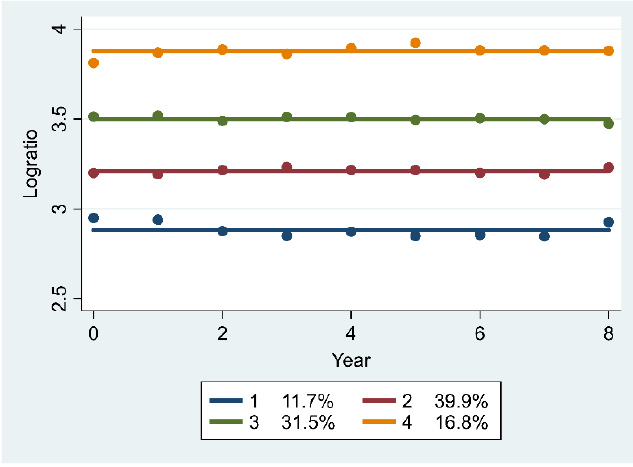
Figure 3. Trajectories of the log-transformed ratio of output to workforce for clinical care ( n = 589).